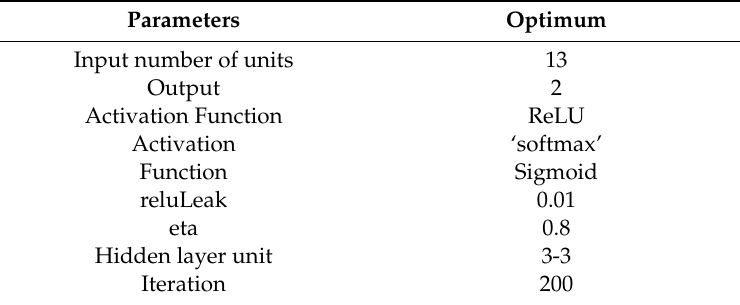
Table 6. Results of optimal parameters in the DLNN model.